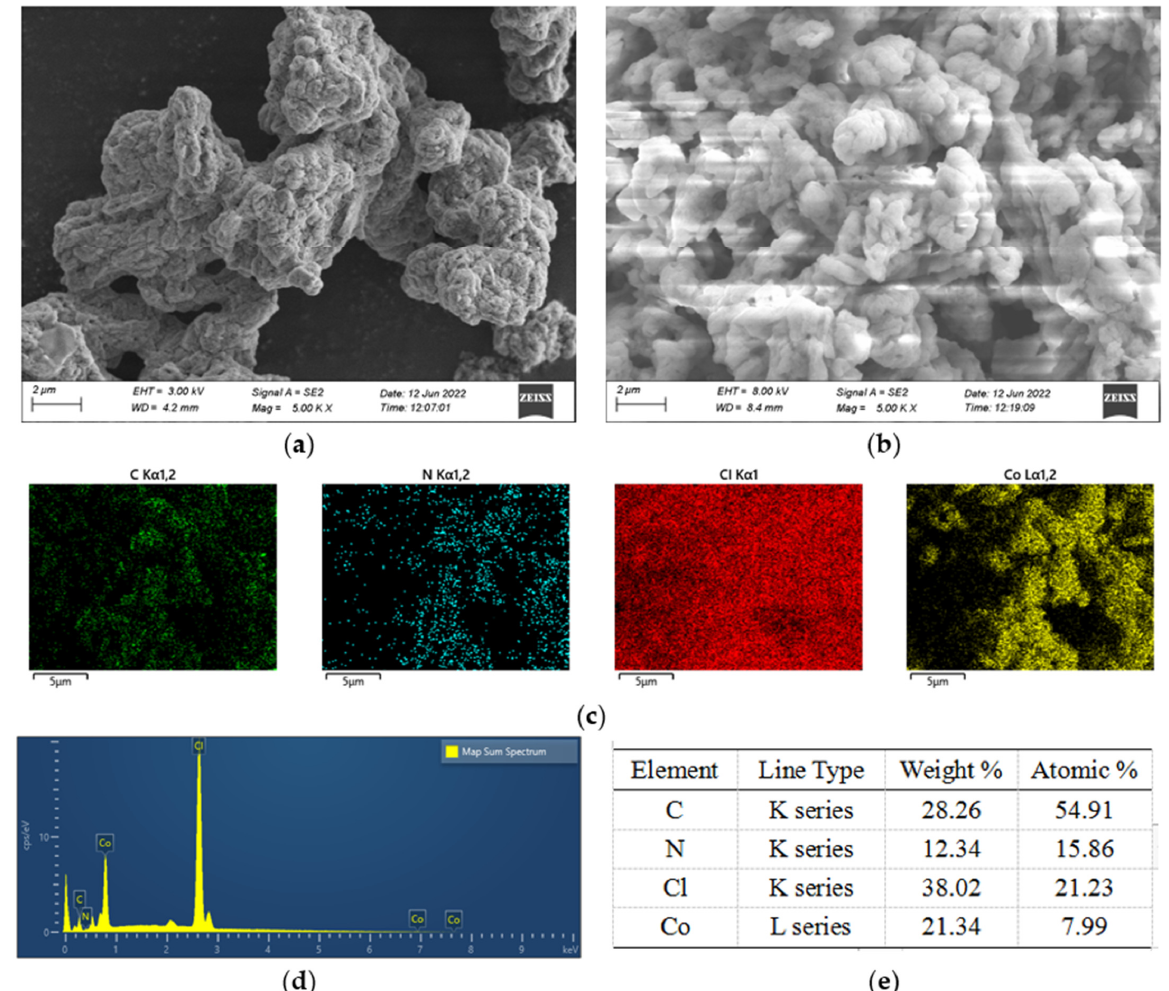
Figure 4. ( a , b ) SEM, ( c ) mapping imagesand, ( d , e ) EDS of di-[EMIM]CoCl